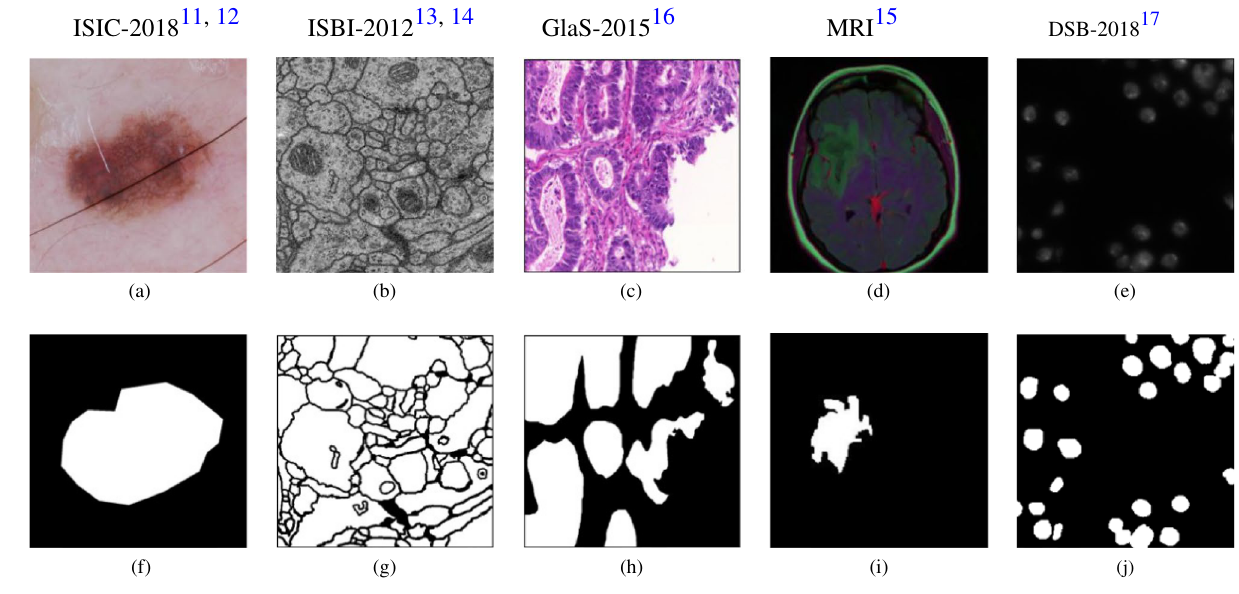
Figure 1. Example images from each publicly available biomedical imaging dataset used in this study. From left to right, the first row shows the images from (a) ISIC-2018 dermoscopy 11,12 , (b) ISBI-2012 13,14 electron microscopy, (c) GlaS-2015 16 histopathology, (d) MRI 15 , and (e) DSB-2018 17 cell nuclei microscopy; the second row (f–j) shows their corresponding segmentation mask used as targets to train the segmentation